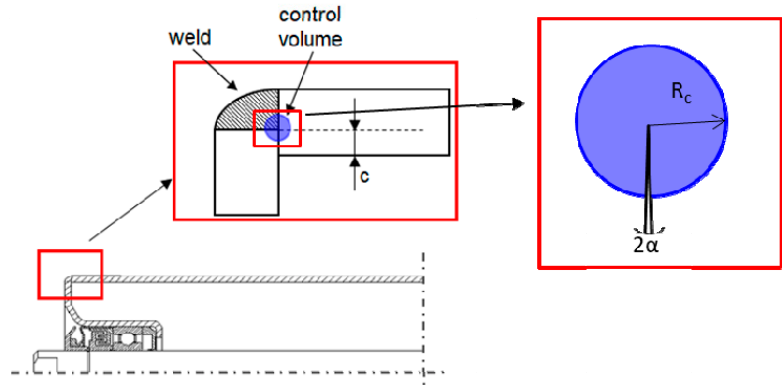
Figure 3. Schematic representation of the weld root, characterized by a weld root length “ c ”, and the control volume of the strain energy density (SED) approach (blue circle).